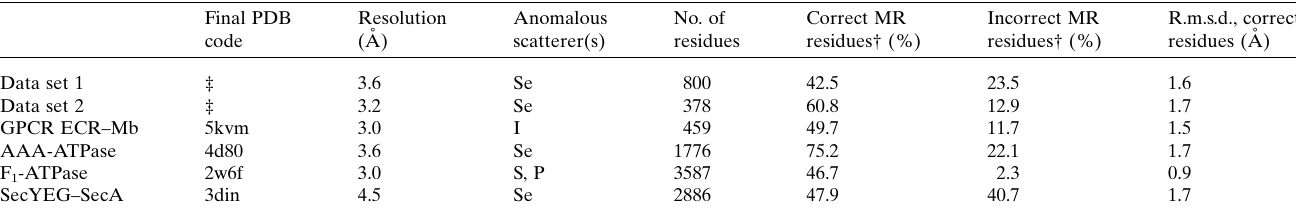
Table 1 Crystal and molecular-replacement model